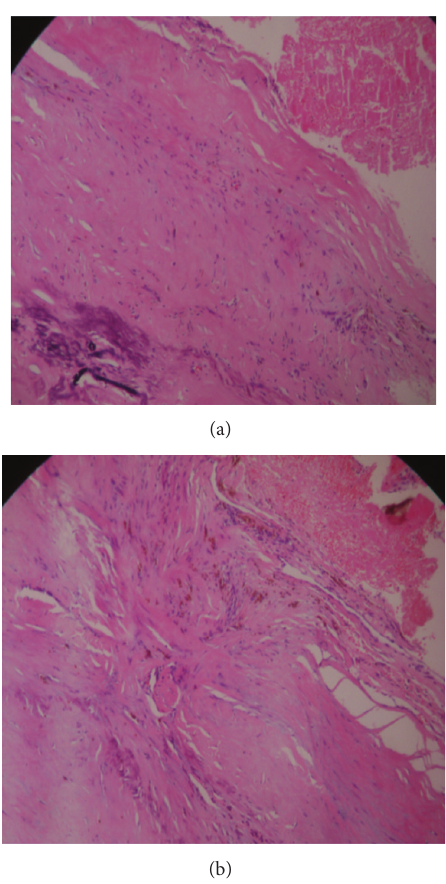
Figure 4: Histology showing a desmoid